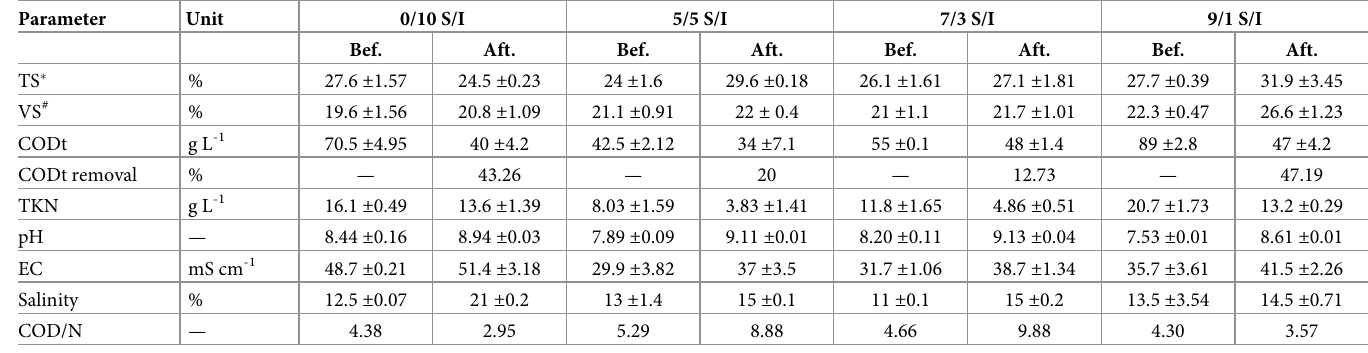
Table 2. Assessment of physicochemical characteristics after 58 days of treatments at 45˚C. The mixed feedstocks were grape marc and cheese whey in ratio 3/1, respectively, before and after digestion at variable substrate-to-inoculum (S/I) ratio: 0/10, 5/5, 7/3, and 9/1. Values recorded as mean ± SE (n = 3).